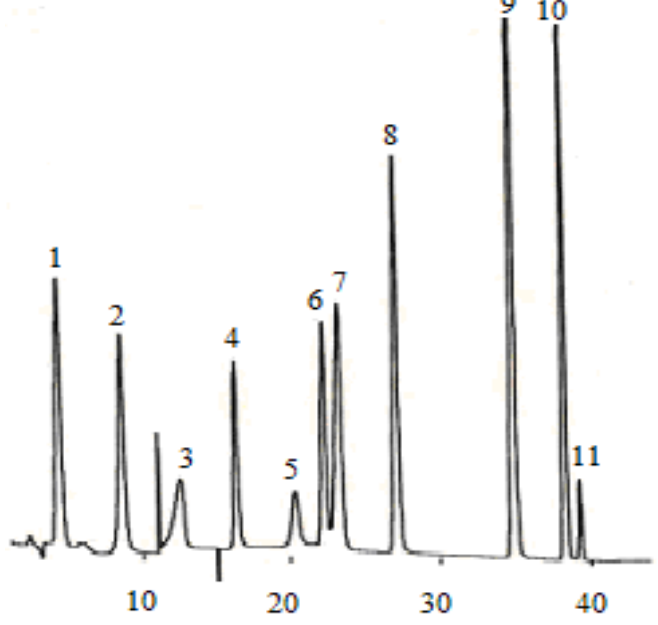
Figure 2. Phenolic acid compounds detected in the dry wine sample. (1) gallic acid, (2) protocatechuic acid, (4) p- hydroxybenzonic acid, (5) chlorogenic acid, (6) vanillic acid, (7) caffeic acid, (8) syringic acid, (9) p- coumaric acid, (10) ferulic acid, (11) sinapic